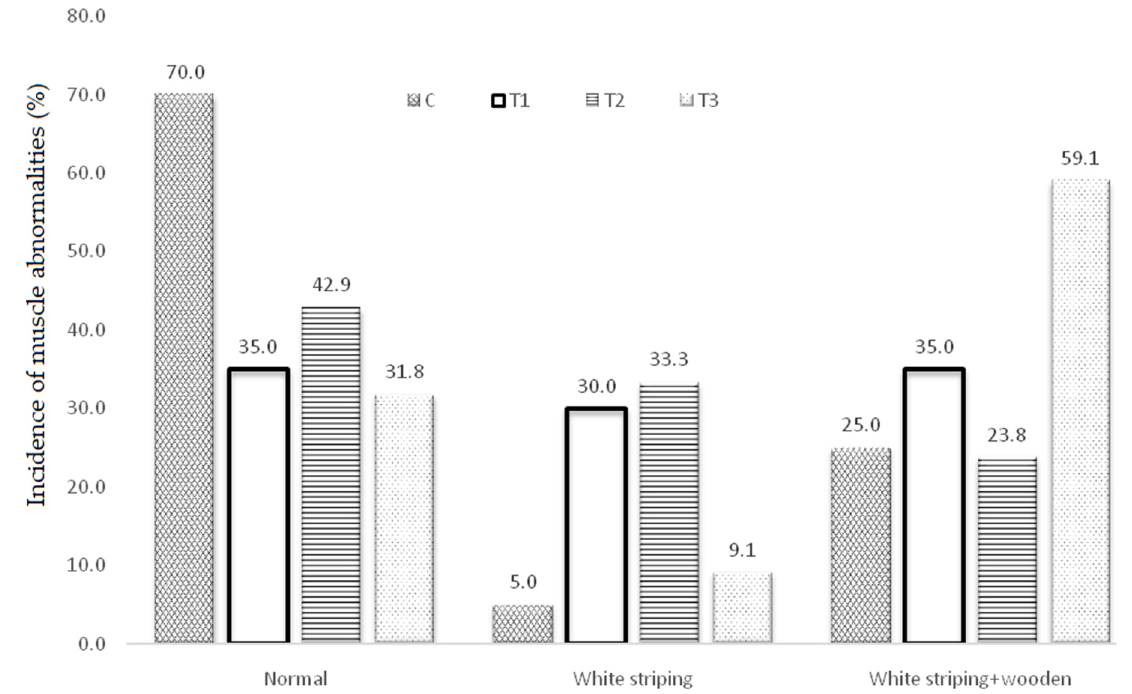
Figure 1. Percentages of normal, white striping, and white striping plus wooden breast meat abnormalities of broilers supplemented with herb extract (HE) ( n = breasts/group). The basal diet (control, C) was similar to regular broiler starter diets, while the experimental treatments of the T1, T2, and T3 birds included the same diet as in the control group, but they were supplemented with herb extracts: thyme essential oil at 350 mg/kg (T1), oregano essential oil at 350 mg/kg (T2), and equal proportions of thyme and oregano essential oils at 350 mg/kg (T3).